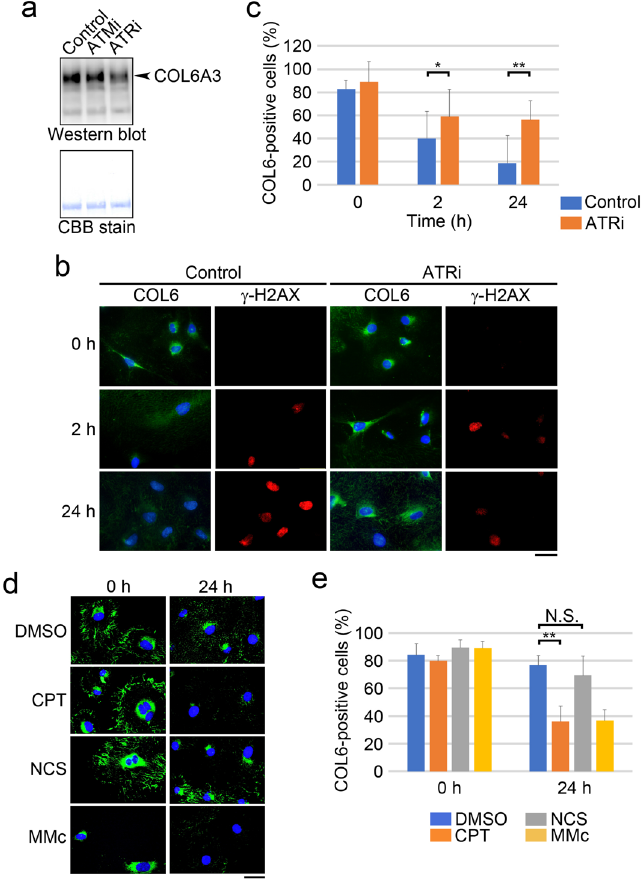
Figure 3. ATR is required for MMc-induced COL6 secretion. ( a ) COL6 in the culture supernatants was detected by Western blotting. HRGECs were cultured with DMSO (control), ATRi or ATMi for 1 h, then MMc (30 µg/mL) was added in the cultures. Twenty-four h after MMc addition, the supernatants were collected. The lower panel showed CBB stain of the same membrane as a loading control. ( b ) HRGECs were cultured with DMSO (control) or ATRi for 1 h, then MMc (12 µg/mL) was added in the cultures. Two h after MMc addition, the cells were washed and cultured with or without ATRi for the indicated number of hours. The cells were then immunostained with anti-COL6 and anti- γ-H2AX antibodies. Scale bar: 50 µm in each panel. ( c ) The percentage of cells with cytoplasmic COL6 (COL6-positive cells) was measured using the samples of b by fluorescent images. ( d ) HRGECs treated with DMSO, CPT (1.0 µM, 4 h), NCS (50 ng/mL, 4 h) or MMc (12 µg/ mL, 2 h) were washed, and cultured without DNA-damaging agents for the indicated number of hours. Cells were immunostained with anti-COL6 antibody. Scale bar: 50 µm in each panel. ( e ) The percentage of cells with cytoplasmic COL6 (COL6-positive cells) was measured using the samples of d by fluorescent images. A total of more than 100 cells of four independent fields per experiment was analyzed. ( c , e ) Statistical significance was determined by the Mann–Whitney U test. * p < 0.05, ** p <